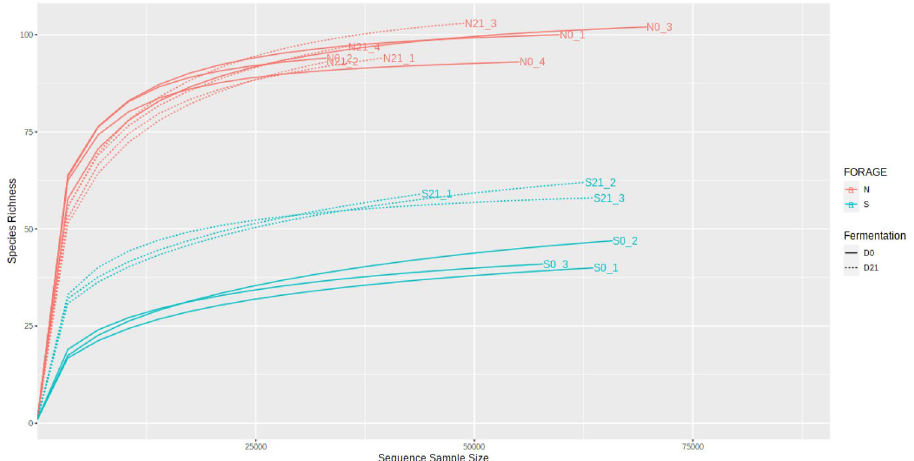
Figure 1. Rarefaction curve of the observed operational taxonomic units (OTUs) of sweet corn and Napier for fresh forage and silage using unrarefied sequences (S0, Fresh sweet corn; S21, Sweet corn silage; N0, Fresh Napier; N21, Napier